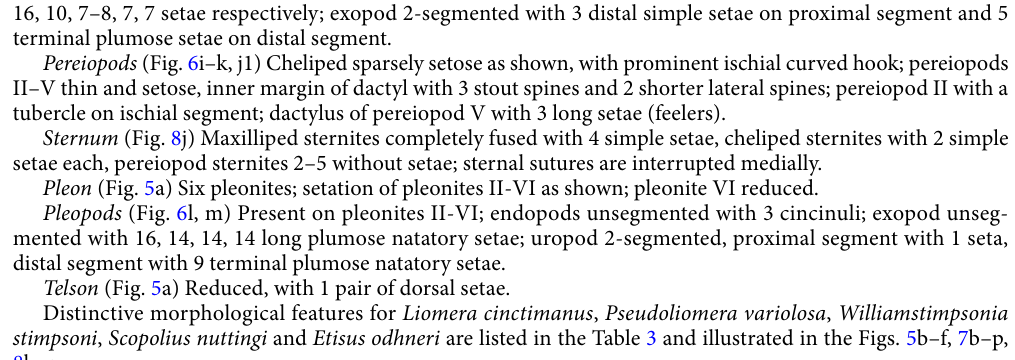
Figure 5. Dorsal view of megalopa: ( a ) Neoliomera cerasinus ; ( b ) Liomera cinctimanus ; ( c ) Pseudoliomera variolosa ; ( d ) Williamstimpsonia stimpsoni ; ( e ) Scopolius nuttingi ; ( f ) Etisus odhneri . Scale bars: 0.5